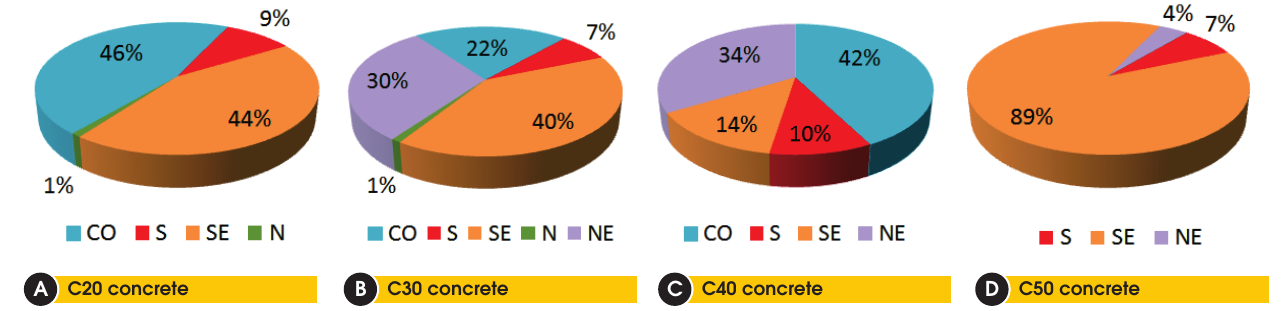
Percentage of sampling data according to the brazilian regions